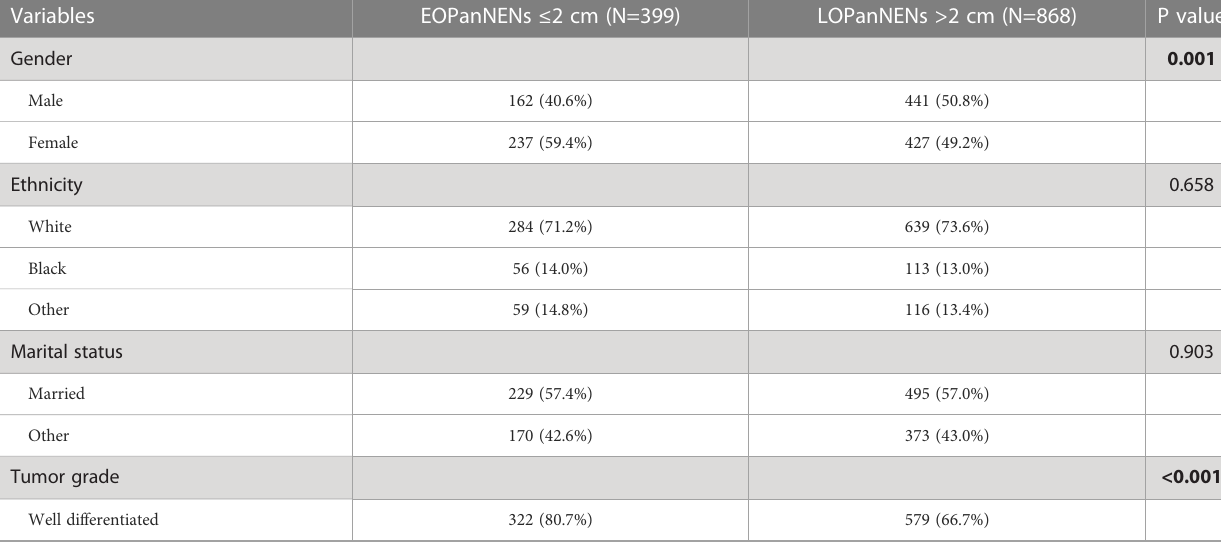
TABLE 3 Patient characteristics of EOPanNENs ≤ 2 cm versus >2 cm in the SEER database.